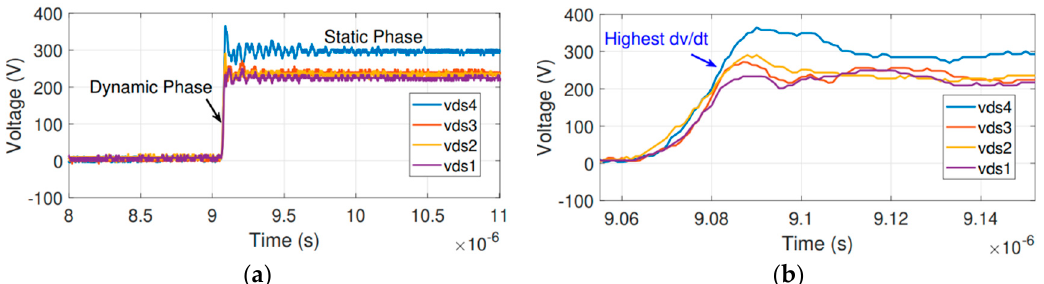
Figure 16. Voltage balancing after adding the traditional planar package ( a ) and its zoomed view ( b ); CASE 2.